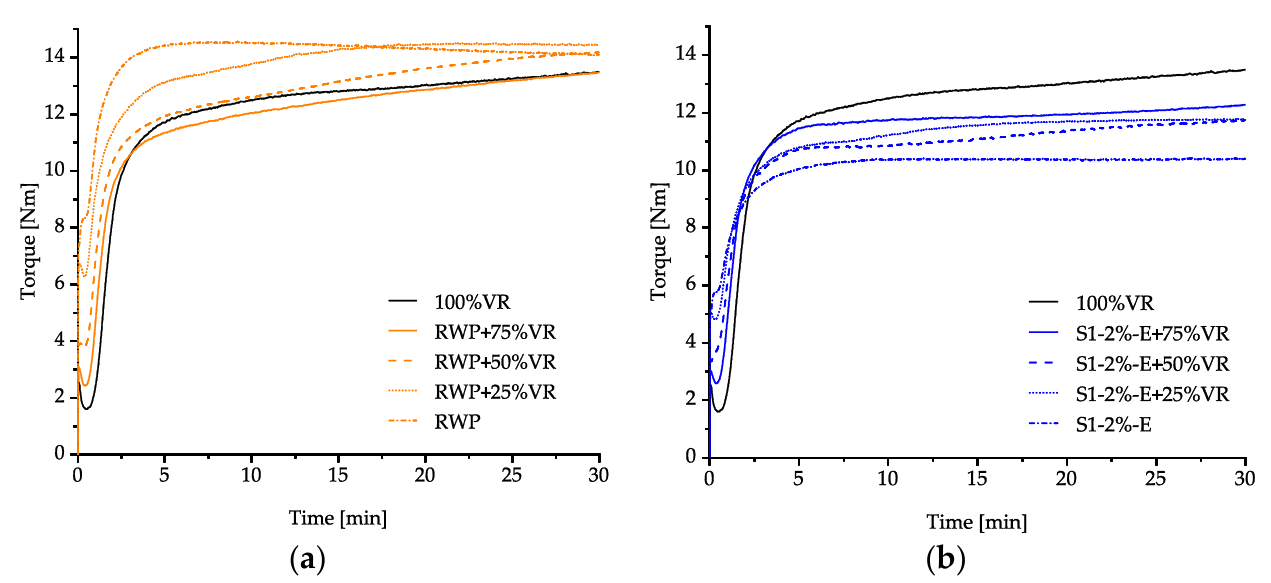
Figure 9. Rheometer curves of VR blends with untreated RWP ( a ) and S1-2%-E (50 rpm, 4.5 gpm) ( b ).